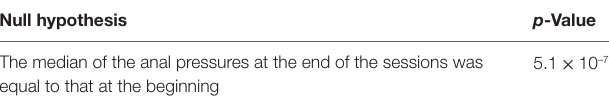
tABLe 5 | p -values obtained regarding the comparisons between the experimental group (submitted to the proposed preoperative biofeedback intervention) and the control